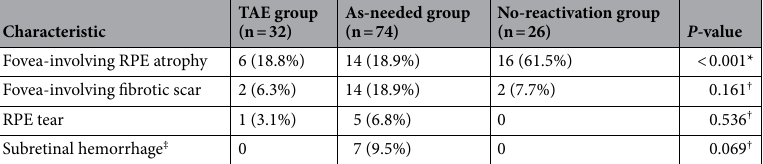
Table 3. Comparison of incidences of pathologic fundus findings and hemorrhage development at 24 month follow-up among the TAE, as-needed, and no-reactivation groups. Data are presented as number (%). TAE treat-and-extend; RPE retinal pigment epithelial. * Statistical analysis with the chi-square test. † Statistical analysis with the Fisher’s exact test. ‡ Incidence of extent of hemorrhage with an area greater than three discs was